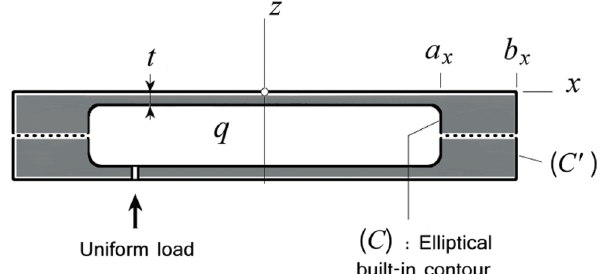
Figure 5: Section of an elliptical closed vase form . This form is made two vase-forms oppositely jointed together in a built-in link. The uniform load q is applied inside the deformable substrate over the elliptical contour C of semi-axe radii ( a , b Outer contour C ′ can be made circular if ( b ) are sufficiently larger than the semi-axe radii of C . x y An extremely rigid outer ring designed for a closed vase form , while polished flat at rest, allows the primary mirror to generate by uniform loading a bi-symmetric optical surface made of homothetic ellipses (Figure 6).